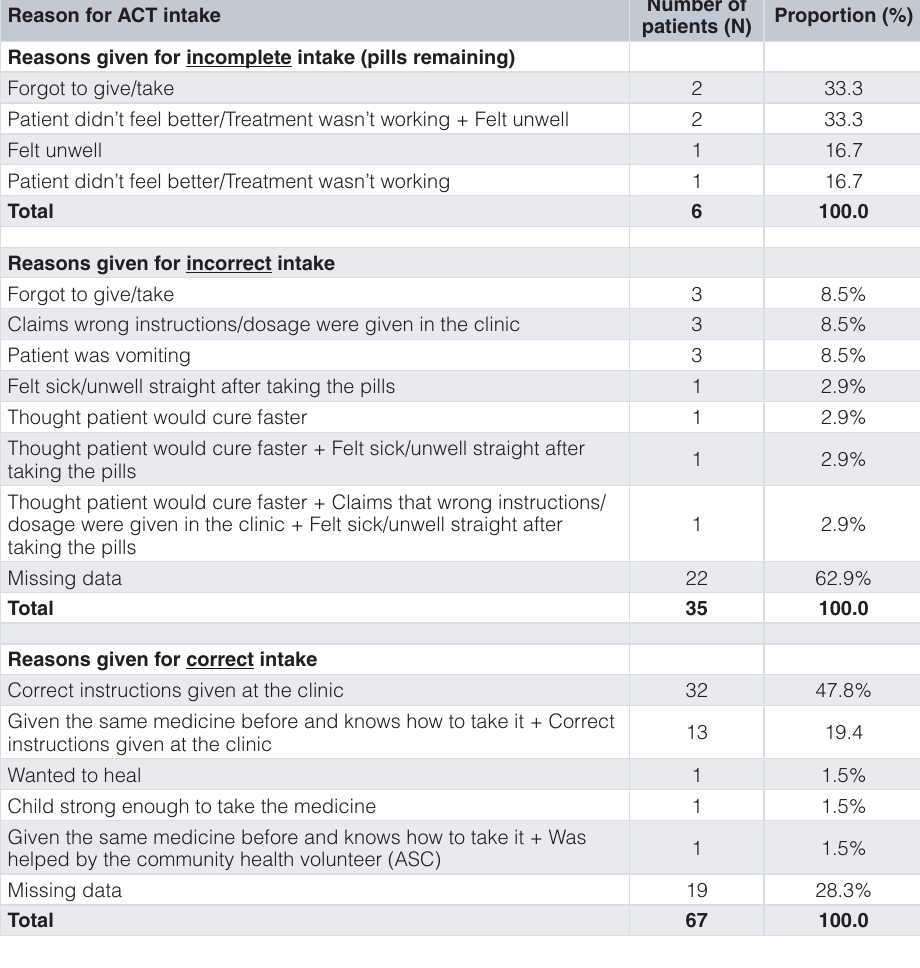
Number of Proportion (%) patients (N)